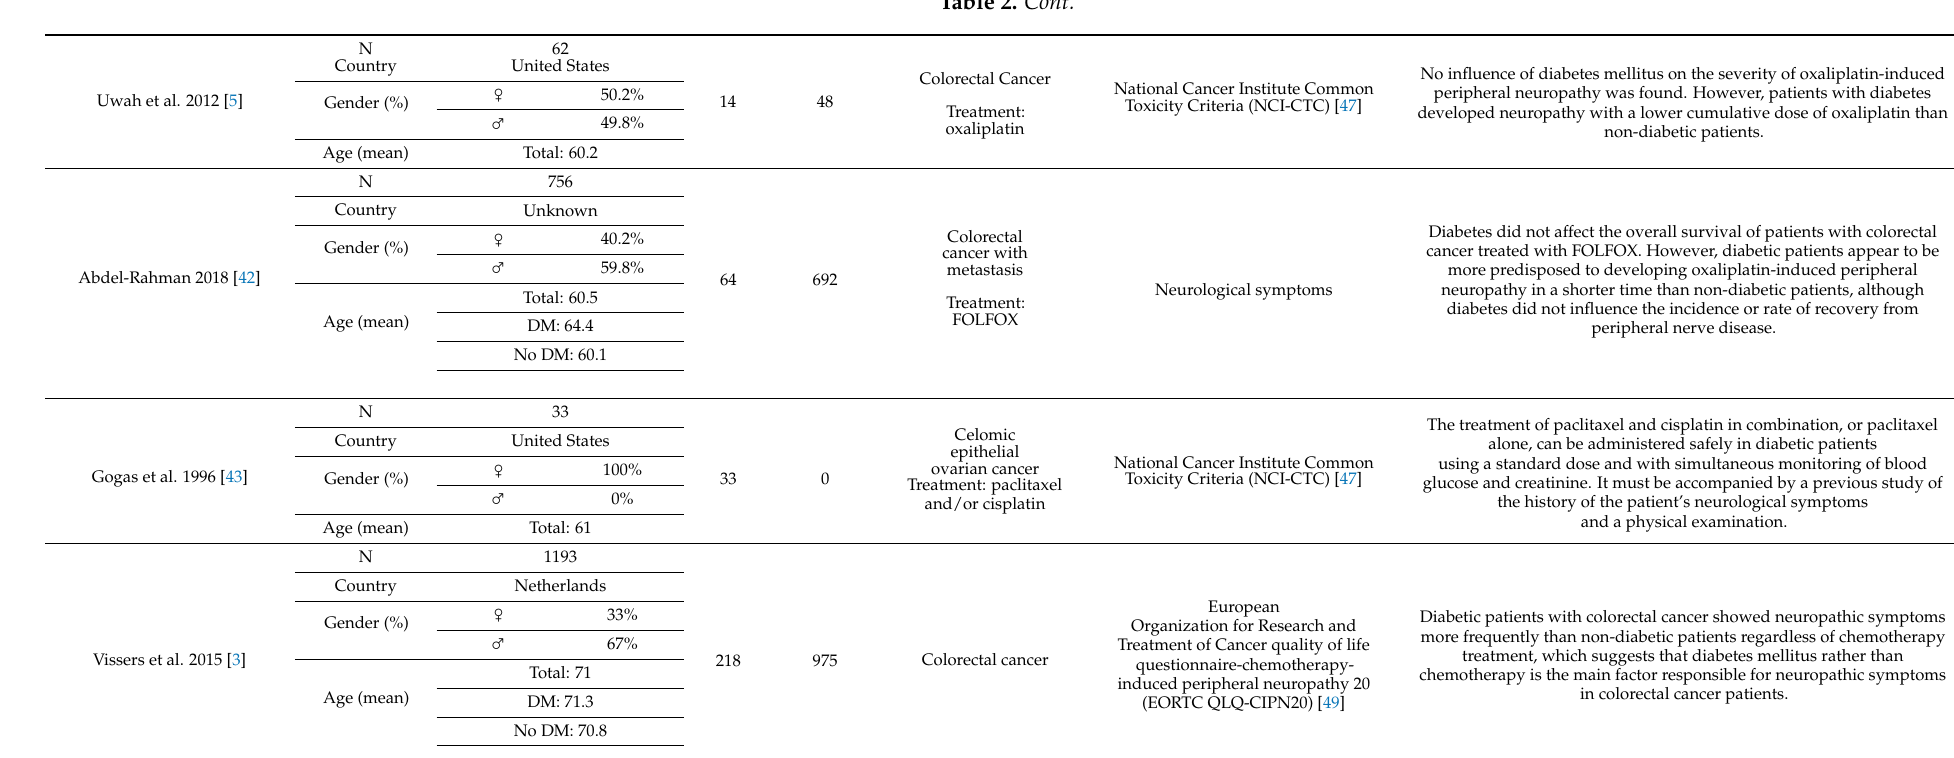
patients.Country